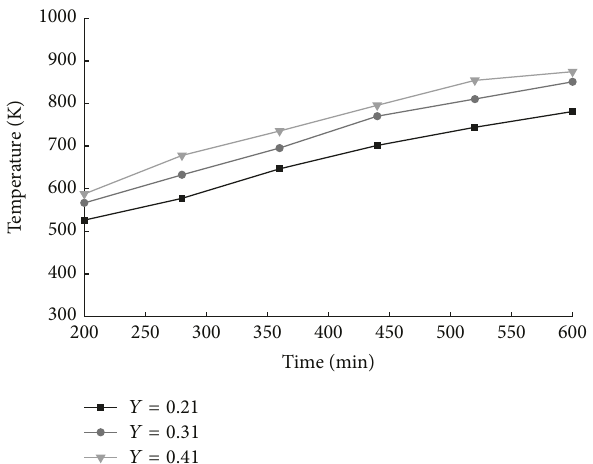
Figure 12: The average temperature of oil shale for different injected oxygen content.